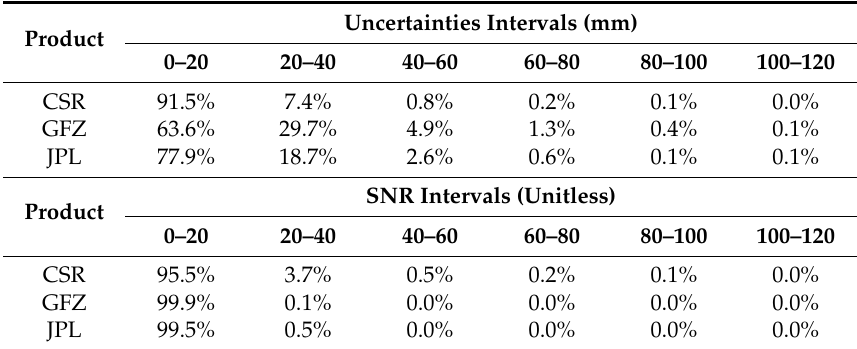
Table 1. Distribution of uncertainties and SNRs for CSR, GFZ, and JPL TWS. The percent shows the percentage of cells lying between (Lower Boundary—Upper Boundary) for each product.